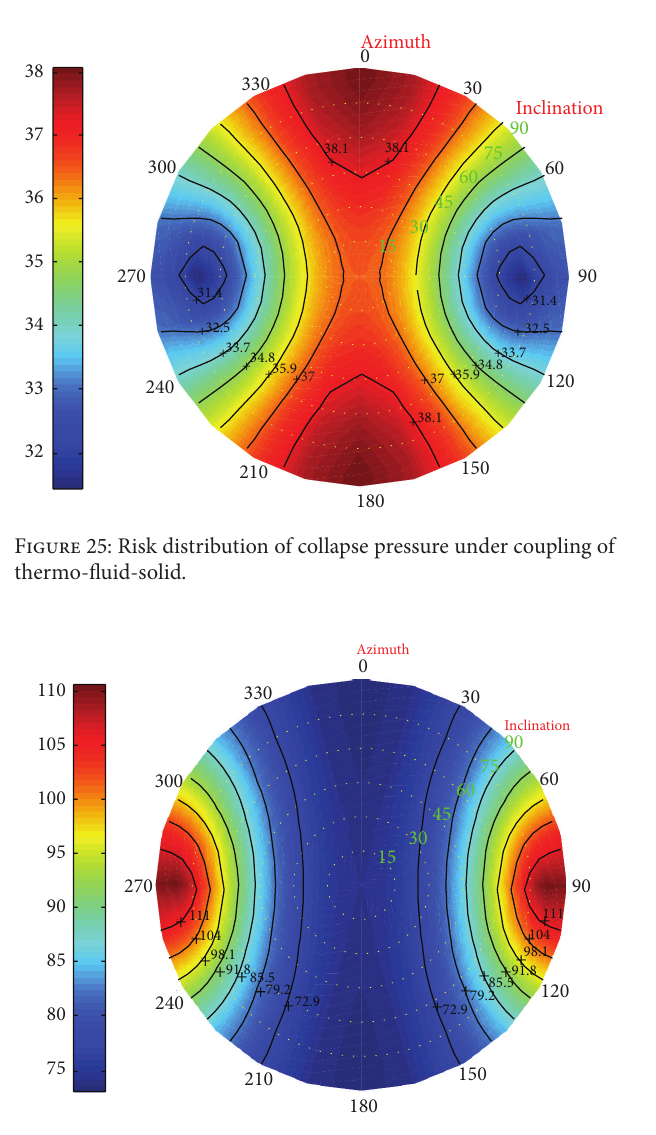
Figure 26: Risk distribution of fracture pressure when permeability coefficient is 0.5.